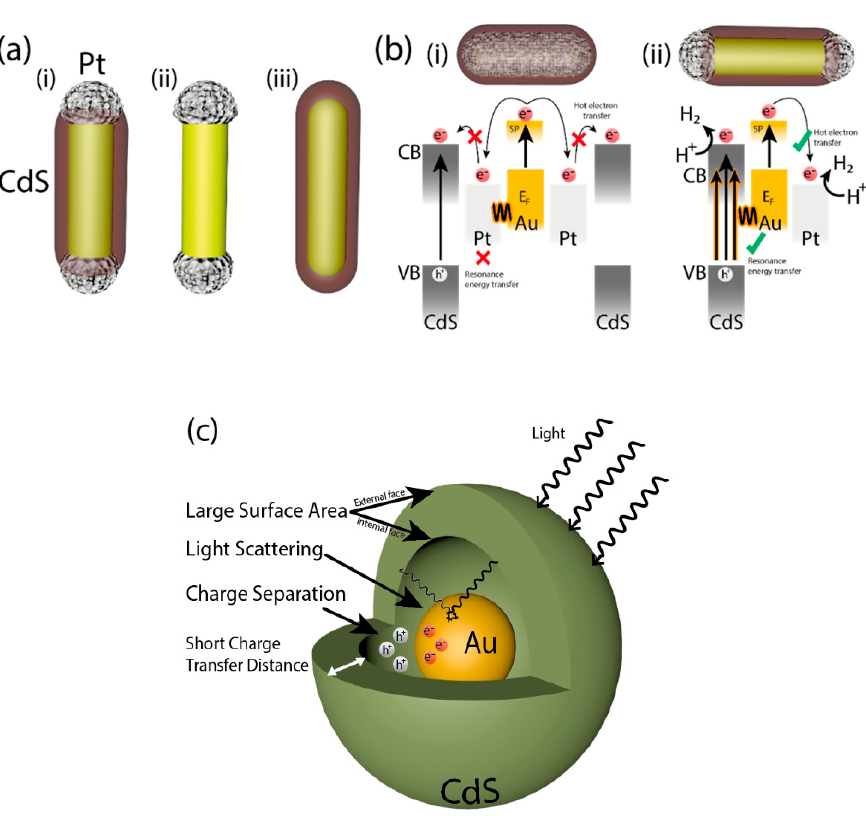
Figure 11. ( a ) Representation of Au-Pt@CdS (i), Au-Pt (ii), Au@CdS (iii) anisotropic hybrid structures; ( b ) schematic representation of energy band multichannel of Au@CdS and Au-Pt@CdS (adapted from [135]) and comparative excitation pathways: Au-assisted CdS charge separation and Au-Pt hot electron transfer is enhanced in the anisotropic structure. Hot electron transfer or RET is not easily achieved when Pt shell is deposited over AuNRs (adapted from [135]); ( c ) schematic representation of photoactivation mechanisms in yolk-shell Au-CdS nanostructures (adapted from [138]).